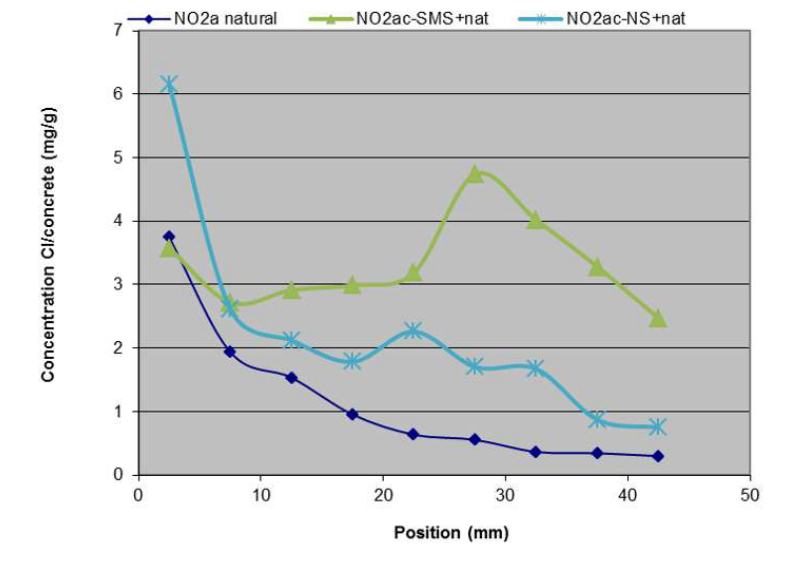
Figure 4. Concentration of chloride ions Normal quality concrete, Natural